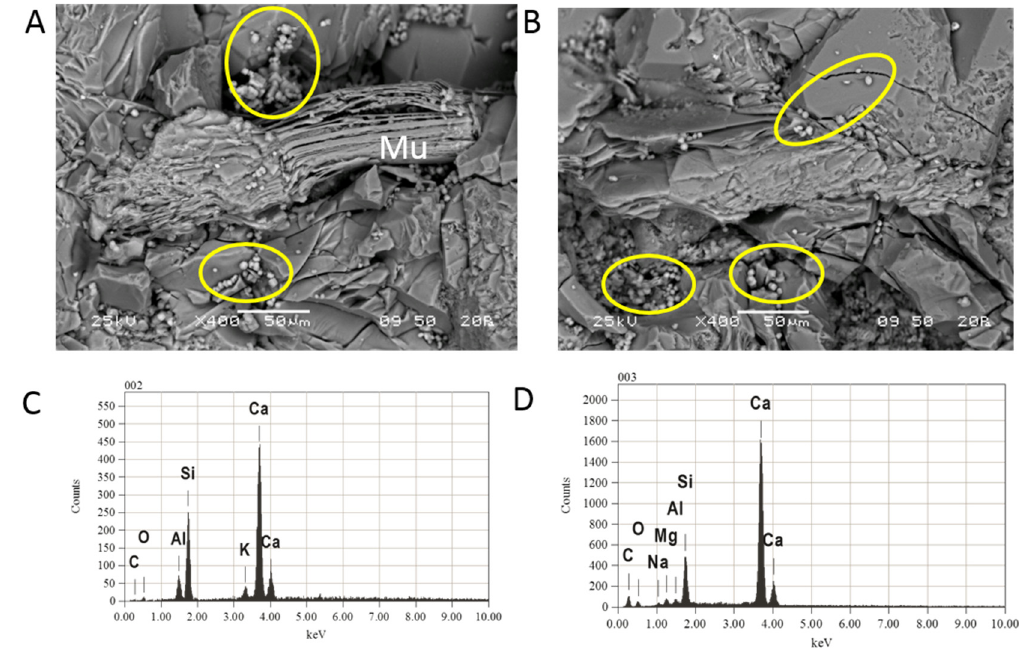
Figure 9. SEM images and EDS of the core block surface after the reaction. ( A , B ) The same surface areas in Figure 4 with fine-grained crystalline precipitates circled. ( C , D ) EDS spectra of precipitates containing Ca. Mu: Muscovite booklets.